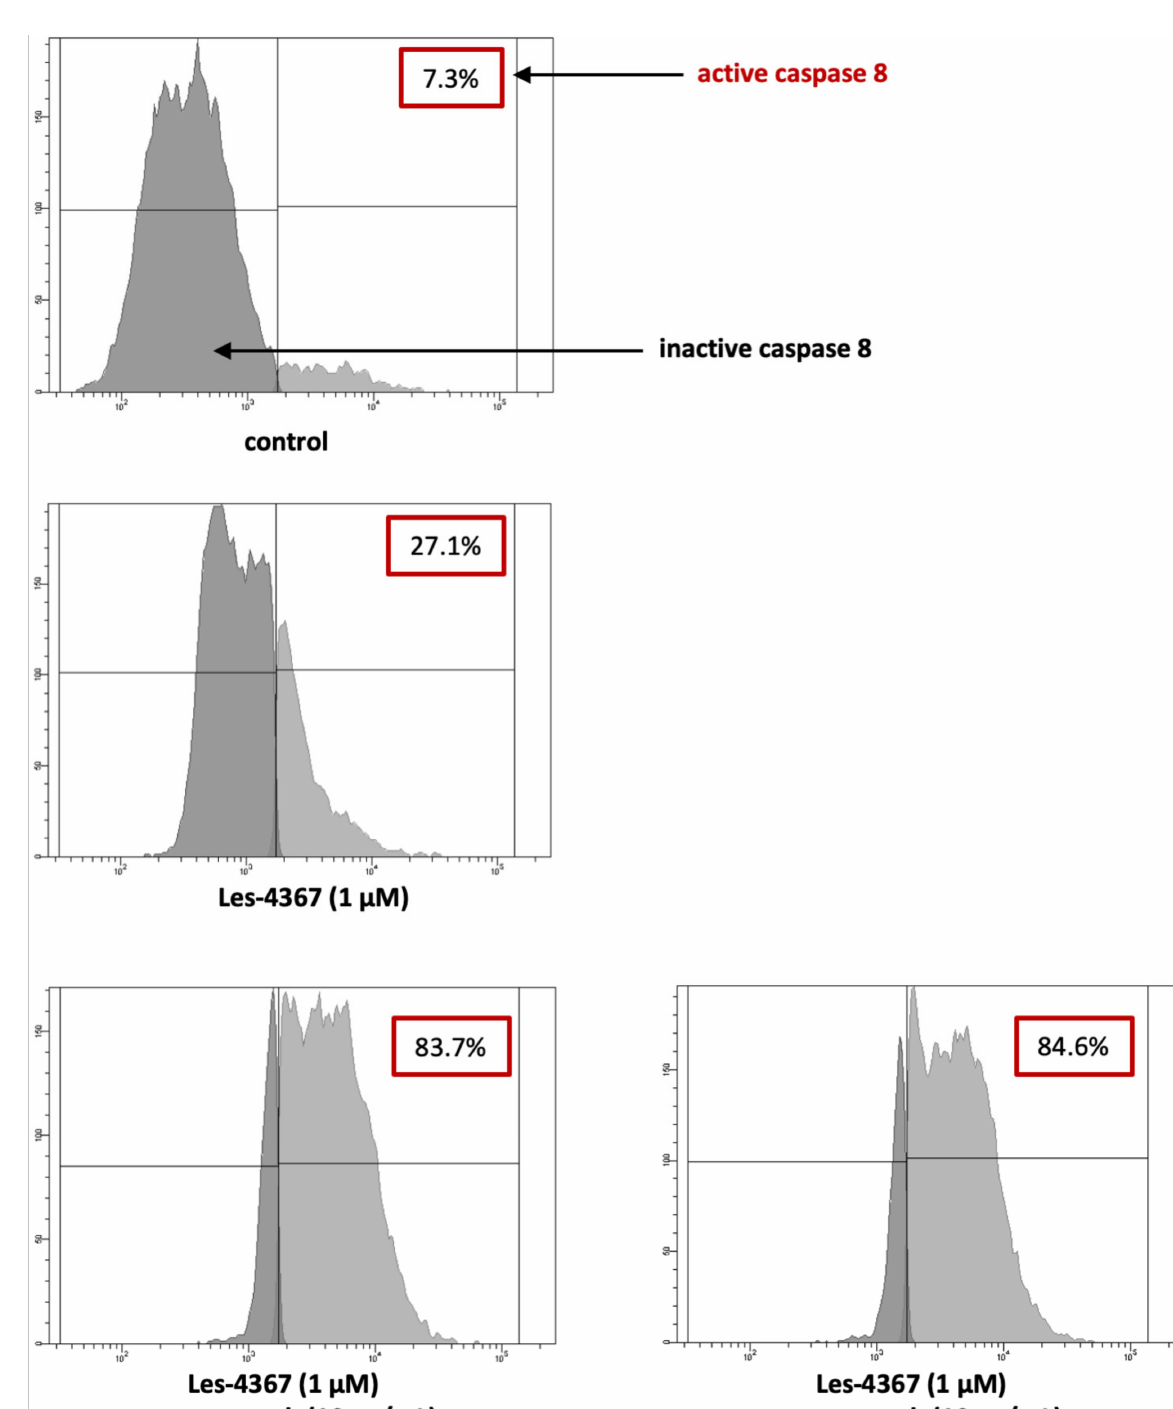
Figure 4. Activity of caspase-8 in AGS cells after 24 h incubation with Les-4367 (1 µ M) and combined with anti-HER2 antibodies. Dark grey part of histogram- cells with inactive form of caspase-8, light grey part of histogram- cells with active form of caspase-8. The ANOVA and Tukey tests were used to demonstrate differences between the control cells and the cells exposed to varying concentrations of the tested